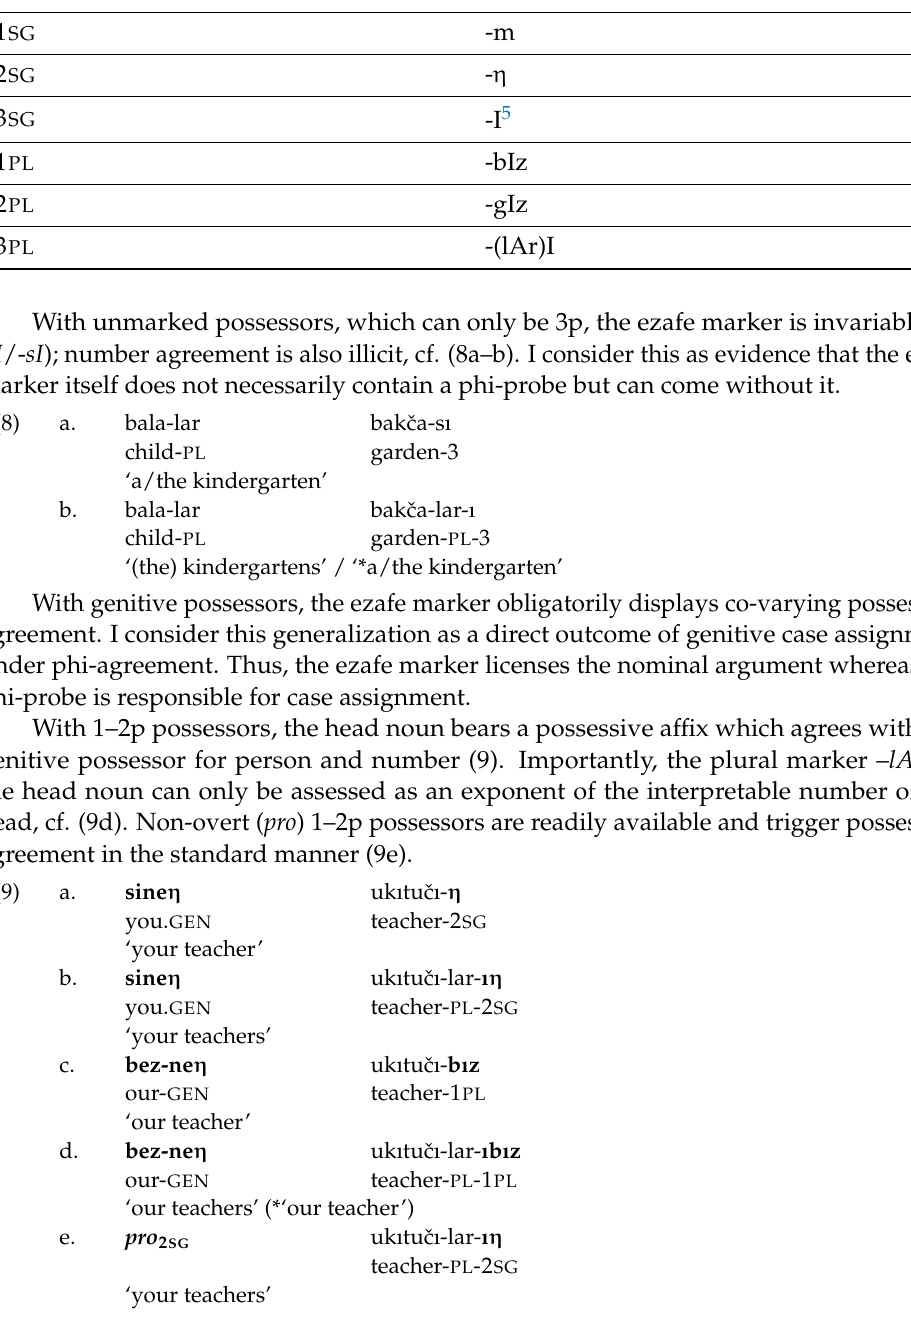
Table 2. Agreement markers in ezafe forms (adapted from Zakiev 1995, vol. 2, p. 32). Possessor’s